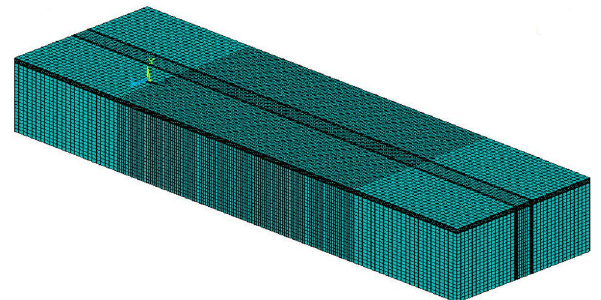
Fig. 1 Model of pavement